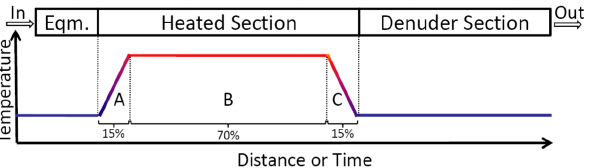
Fig. 1. Schematic of the thermodenuder model. Note that the tem- perature changes in the heated section take place over a distance. The heating zone is indicated by “A”, the hot zone by “B” and the cooling zone by